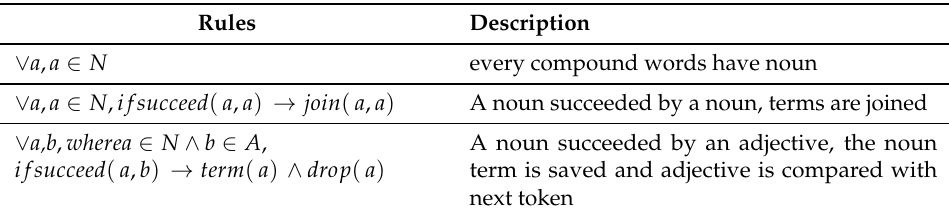
Table 2. Compound words identification and extraction rules.